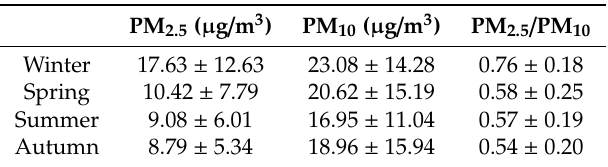
Table 2. Average concentrations and the standard deviations of particulate matter (PM) and the ratios of PM 2.5 / PM 10 in the four